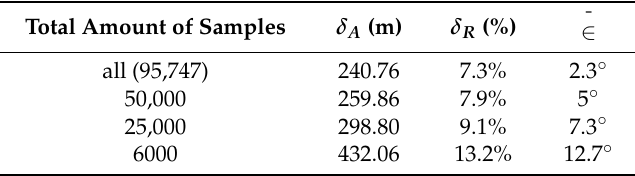
Table 4. Performance Comparison for Different Sample Volumes.